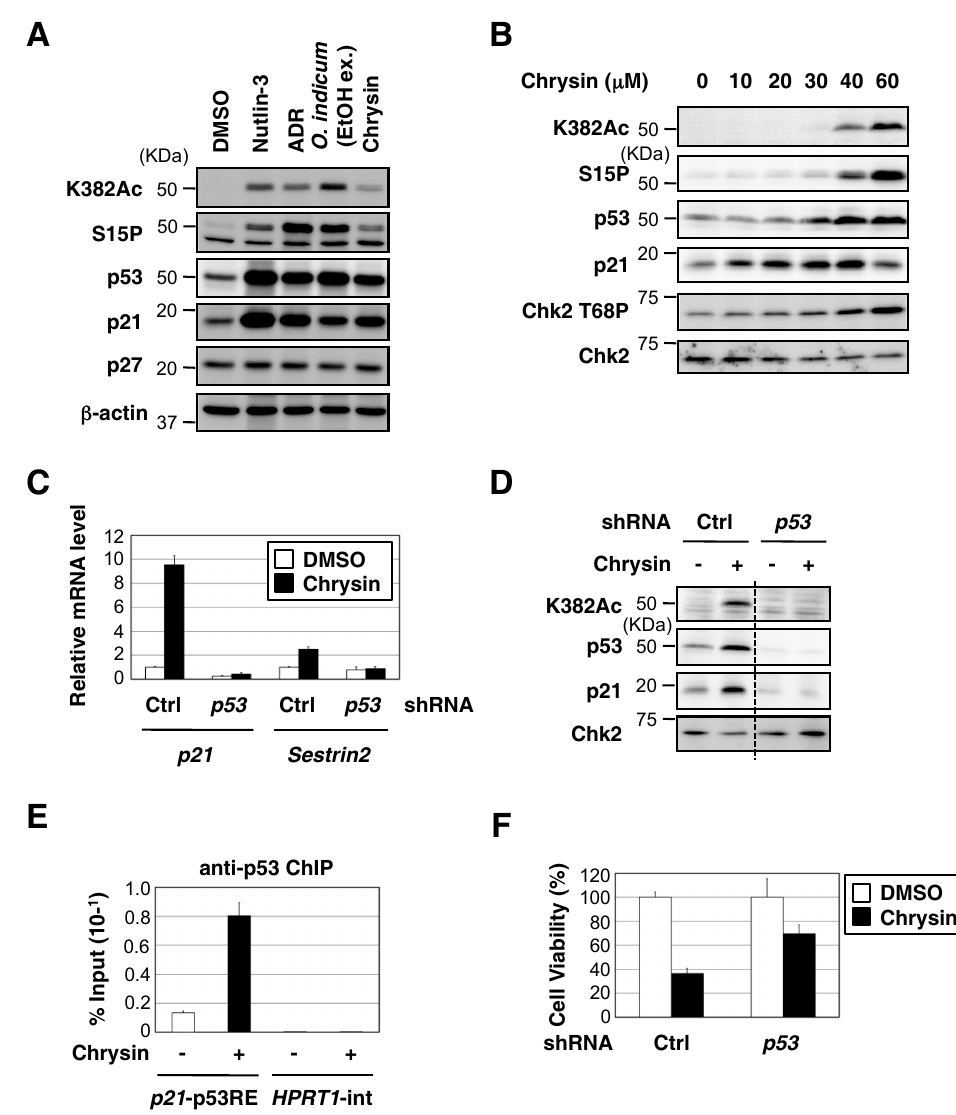
Figure 2. Chrysin increased p53 protein expression and the p53-mediated expression of downstream target genes, and decreased cell viability in a p53-depemdent manner. ( A ) MCF7 cells were treated with Nutlin-3 (10 µ M), ADR (0.3 µ M), the ethanol extract of O. indicum bark (100 µ g/mL), or chrysin (40 µ M) for 8 h. Cell lysates were immunoblotted with the indicated antibodies. ( B ) MCF7 cells were treated with the indicated doses of chrysin for 8 h. Cell lysates were immunoblotted with the indicated antibodies. ( C ) shcontrol-MCF7 and shp53-MCF7 cells were exposed to 40 µ M of chrysin for 8 h. The expression of each gene was assessed by qPCR. ( D ) shcontrol-MCF7 and shp53-MCF7 cells were exposed to 40 µ M of chrysin for 8 h. Cell lysates were immunoblotted with the indicated antibodies. ( E ) MCF7 cells were exposed to 40 µ M of chrysin for 6 h. ChIP was performed using an anti-p53 antibody, and qPCR was conducted for the indicated promoters. ( F ) shcontrol-MCF7 and shp53-MCF7 cells were exposed to 40 µ M of chrysin for 48 h. Cell viability was measured by the WST-8 cell proliferation